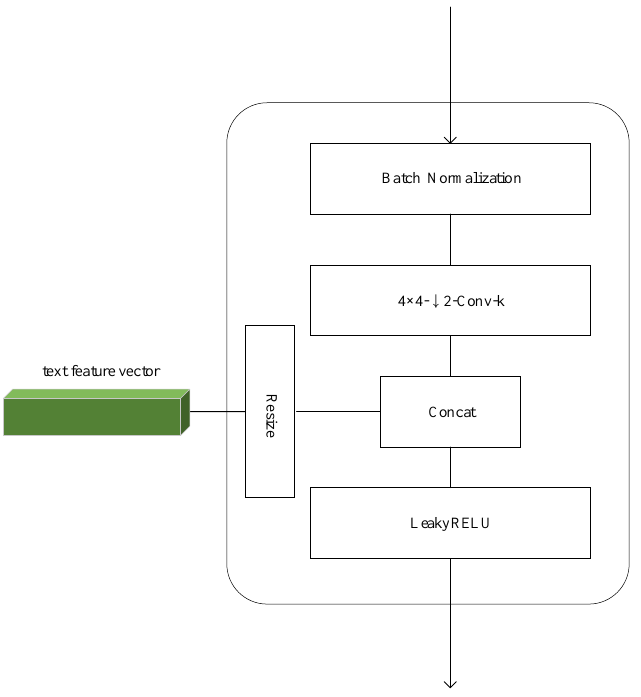
Figure 5. The down-sampling module of